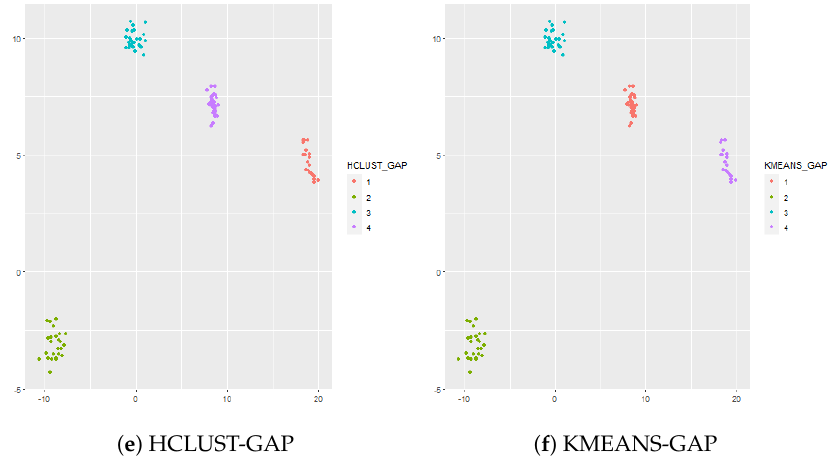
Figure 1. Panel ( a ) shows the true cluster assignments when p = 2, K ∗ = 4, and n = 110. Panel ( b ) shows the posterior TIP cluster assignments, Panel ( c ) shows the posterior EPA assignments, Panel ( d ) shows the MCLUST assignments, Panel ( e ) shows the hierarchical clustering assignments (complete linkage) where the number of clusters is determined via the gap statistic, and Panel ( f ) shows the k-means clustering assignments where the number of clusters is determined via the gap statistic.